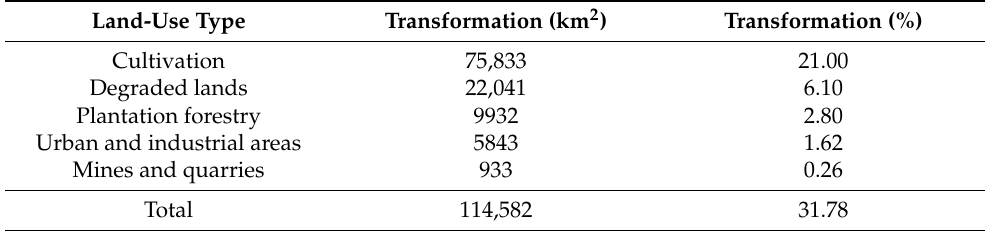
Table 1. Land-use types responsible for the greatest transformation in the Grassland Biome of South Africa, Lesotho and Eswatini [24,28]. These drivers account for a cumulative transformation total of ca. 32%. Large impoundments (ca. < 0.2%), formal protected areas (ca. 2%) and extensive farming practices for livestock and wildlife (ca. 66%) account for the remaining grassland area. This spatial assessment was based on a GIS analysis using ArcGIS (WGS84 datum–Lo29 projection). Areas of transformation were derived from the National Land Cover 2000 coverage (satellite